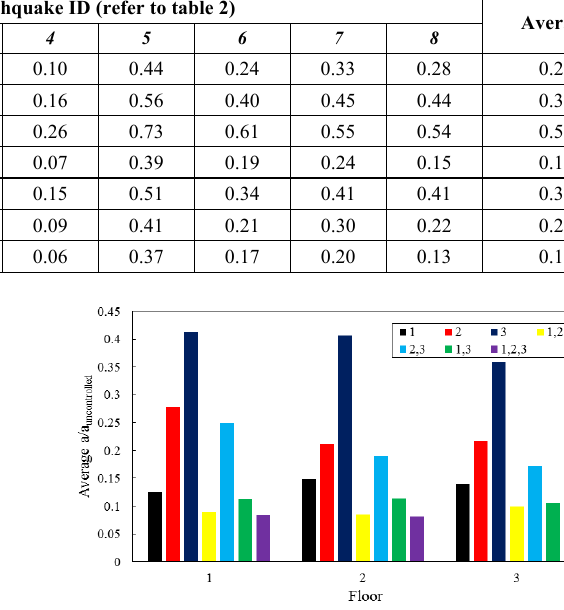
Figure 6. Comparing controlled and uncontrolled acceleration at different floors for different dampers’ arrangements under Kobe Earth-